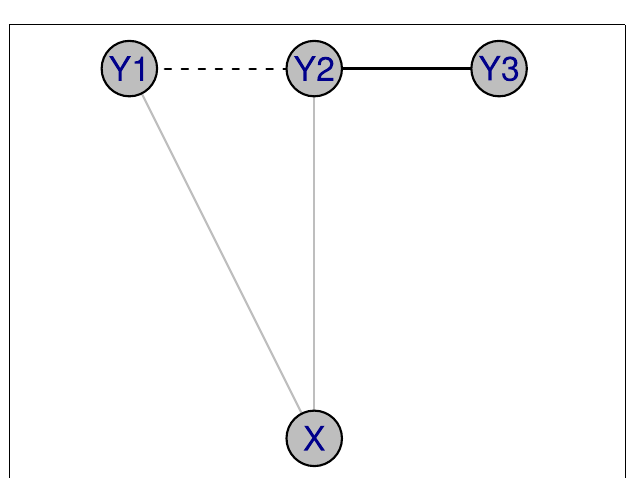
FIGURE 1 | Illustration of conditional GGM: X represents a single molecular marker, and Y 1 , Y 2 , Y 3 represent the expressions of three genes. When the marker effect is ignored, there are two edges in a graphical model: 1 ↔ 2 and 2 ↔ 3. After considering the marker effect, there is a single edge, represented with a solid line, in a conditional graphical